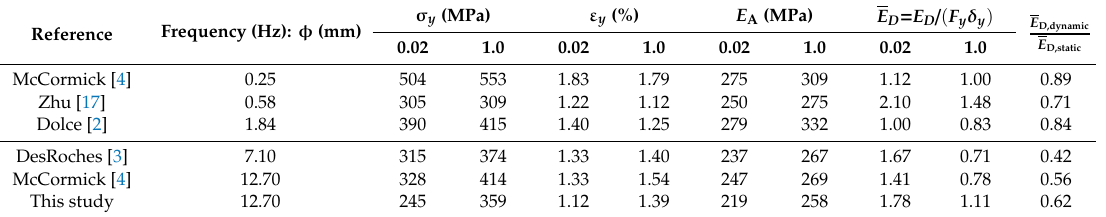
Table 1. Energy dissipated in a single cycle at ε = 6% amplitude and di ff erent